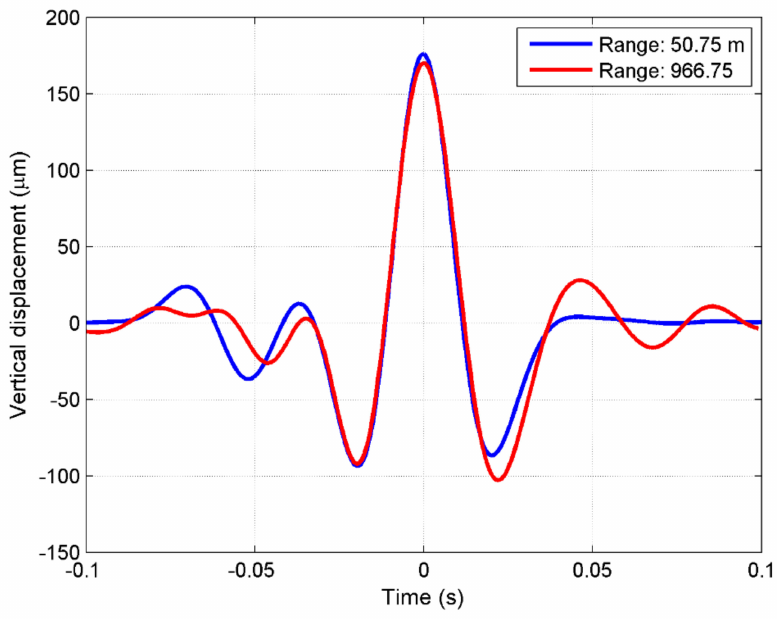
Figure 7. The wavelet changes shape with time and distance. Here, data from two nodes at different distances (1680 at 50.75 m, 9002 at 966.75 m) are shown offset in time and scaled by a cylindrical √ spreading factor of (966.75/50.75) in